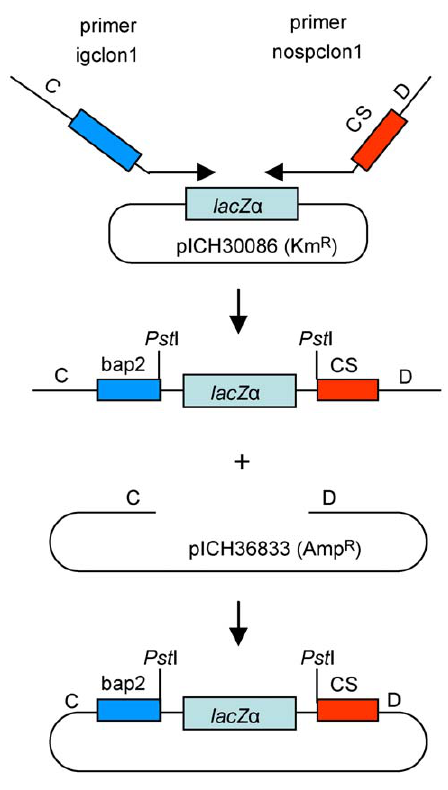
Figure 10. Construction of QC cloning vectors. QC cloning vectors can be prepared by amplification of a DNA fragment containing a visible selectable marker (a lacZ a fragment was used here) with two primers with 5 9 extensions containing the bap2 sequence (blue box) and the catching sequence (CS, red box). The primers also contain extensions C and D with homology with any cloning vector of choice. The PCR product is cloned by ligation-independent cloning in a linearized vector (here pICH36833) with DNA ends homologous to sequences C and D. DNA from blue colonies are sequenced to make sure that no mutations are present in the sequence of bap2 and the